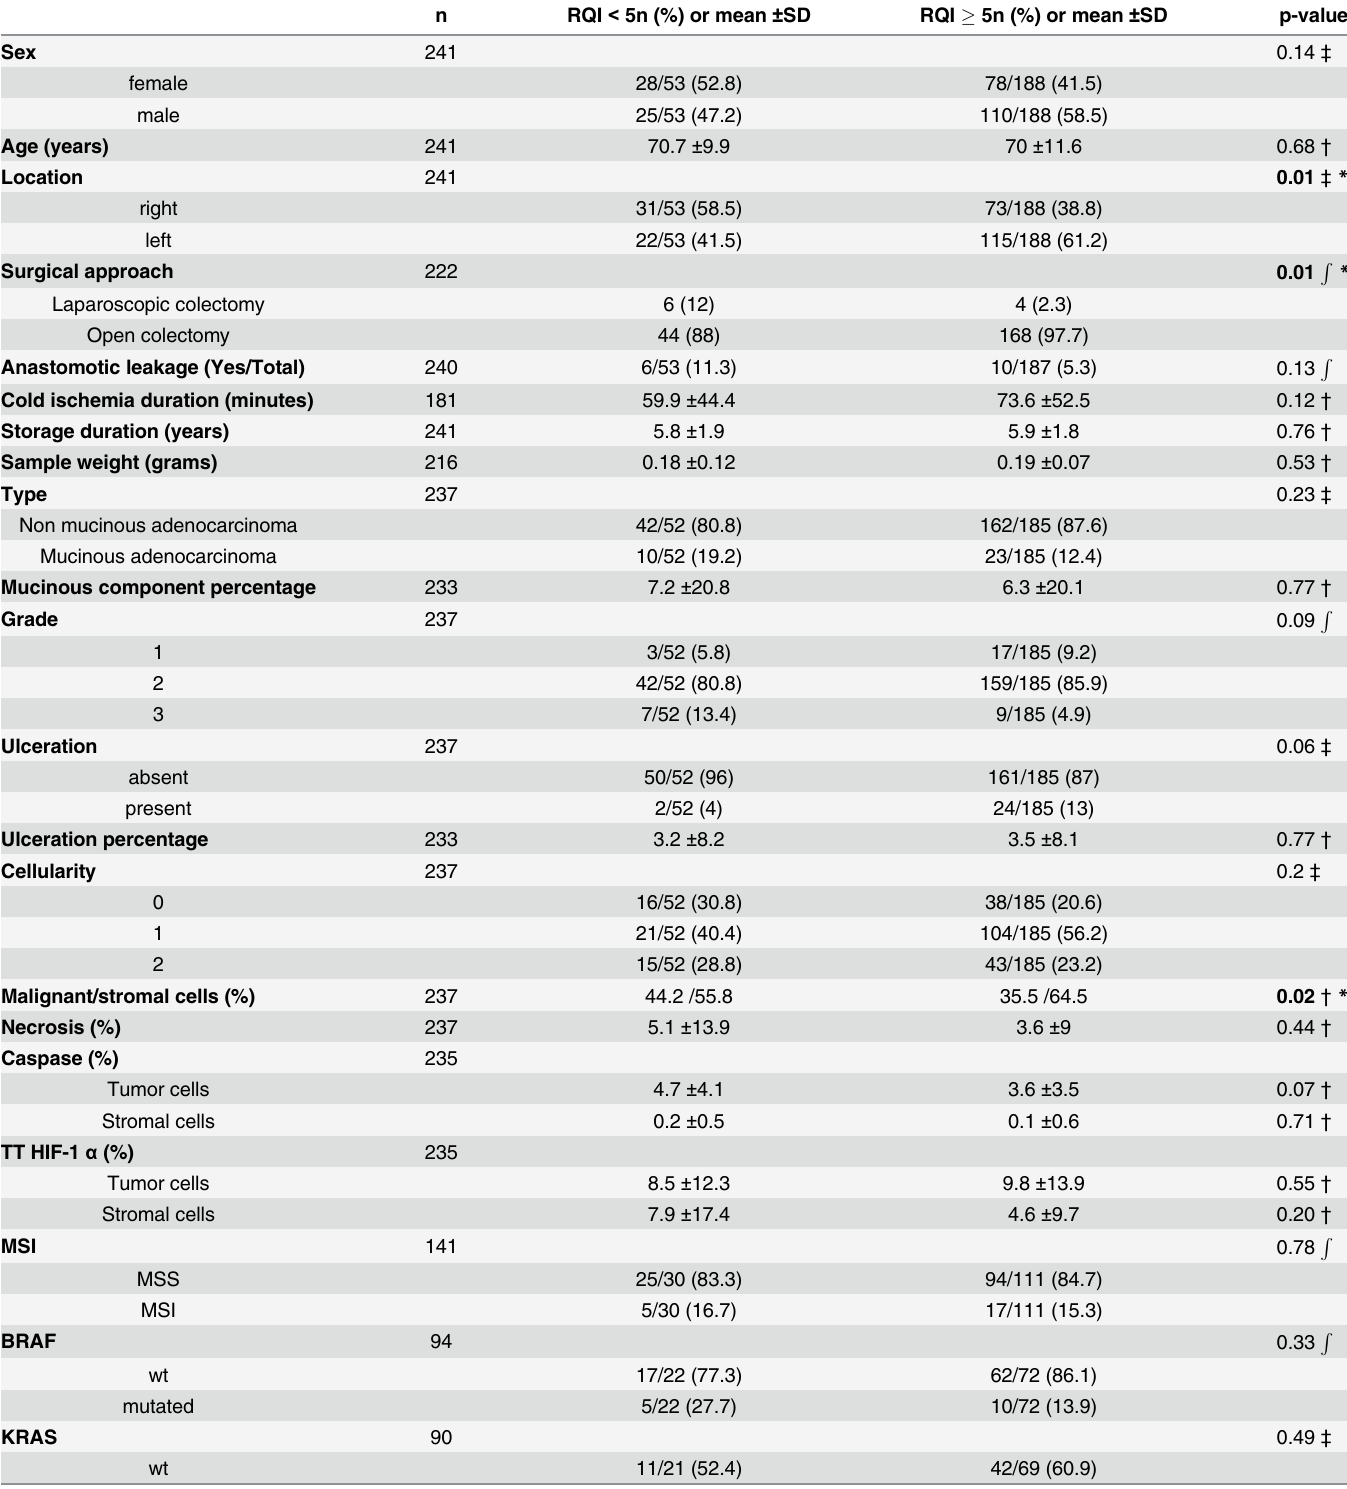
Table 3. Parameters associated with RNA quality in tumoral